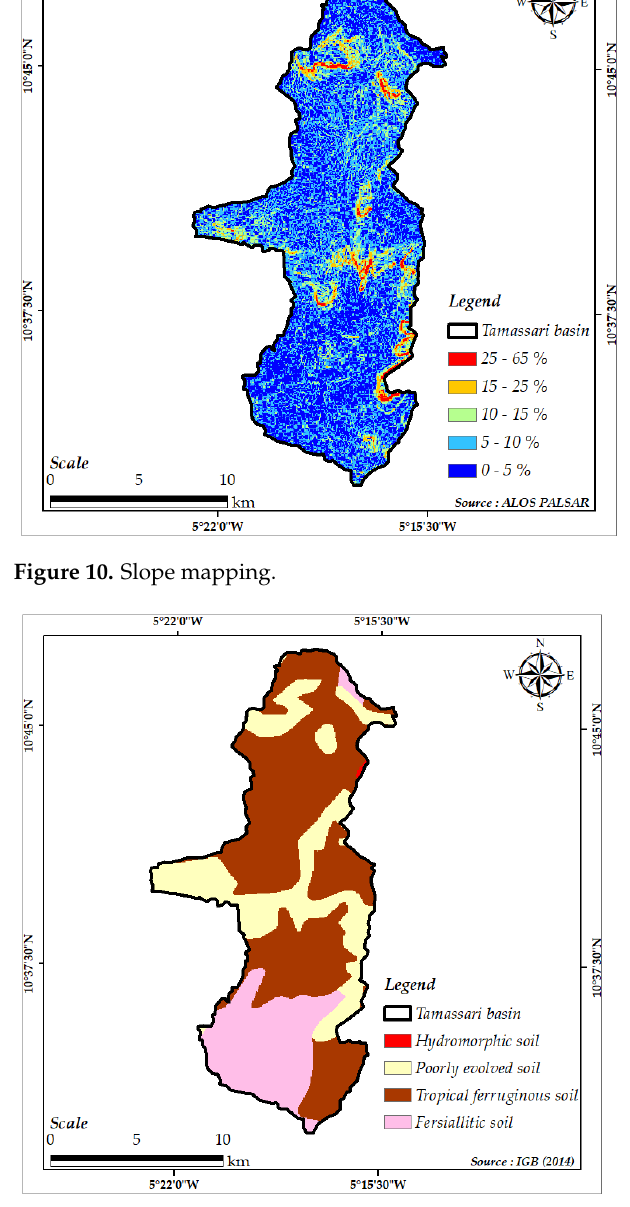
Figure 11. Soil type mapping.